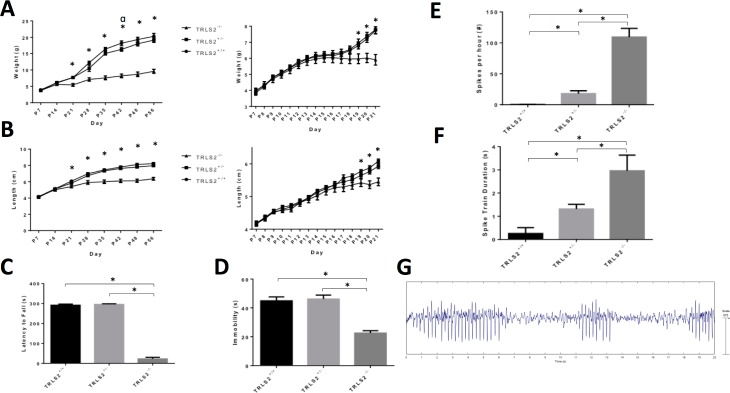
TRLS/2J mice show similar phenotypes to other mutant mice lacking HCN2 expression.A) Weights and B) lengths of Trls2+/+, Trls2+/-, and Trls2-/- mice were obtained daily from P7 to P21 (right graphs) and weekly until P56 thereafter (left panel). Trls2-/- mice began to fall of the growth curve between P14 and P21. (Repeated Measures Two-Way ANOVA. Weekly Weight: FTime(7,196) = 385.9, p < 0.0001; FGenotype(2,28) = 65.39, p < 0.0001, FInteraction(14,196) = 33.42, p < 0.0001. Weekly Length: FTime(7,196) = 676.9, p < 0.0001; FGenotype(2,28) = 36.58, p < 0.0001; FInteraction(14,196) = 27.09, p < 0.0001. Pre-weaning Weight: FTime(14,532) = 352.7, p < 0.0001; FInteraction(28,532) = 12.75, p < 0.0001. Pre-weaning Length: FTime(14,560) = 468.5, p < 0.0001; FInteraction(28,560) = 5.815). Tukey’s Post Hoc Test was used to detect individual differences between groups. An * denotes p < 0.05 between Trls2+/+ and Trls2-/- as well as between TRLS2+/- and TRLS2-/-. An α denotes p < 0.05 between Trls2+/+ and Trls2+/-. C)
Trls2-/- mice showed significantly shorter latencies to fall on the RotaRod (One-Way ANOVA. F(2,29) = 543.4, p < 0.0001; Tukey’s Post Hoc Test p < 0.05). D)
Trls2-/- mice showed significantly reduced immobility on the Tail Suspension Test (One-Way ANOVA. F(2,29) = 12.46, p < 0.0001; Tukey’s Post Hoc Test p < 0.05). E) During a 24hr monitoring period, one-way ANOVA revealed differences in the frequency (F(2,28) = 140.1, p < 0.0001) and F) durations (F(2.28) = 18.68, p < 0.0001) of Spike-Wave Discharges (SWDs) by genotype, and Trls2-/- mice showed persistent SWDs while Trls2+/- had prominent but fewer SWDs. Tukey’s Post Hoc Tests demonstrated that all groups exhibited different frequencies and durations of SWDs (p < 0.05). G) Representative 20s epoch of EEG from Trls2-/- mouse. Significance (p < 0.05) is denoted with an *, and error bars represent Standard Error of the Mean. (n+/+ = 10–13, n+/- = 12–19, n-/- = 5–10).